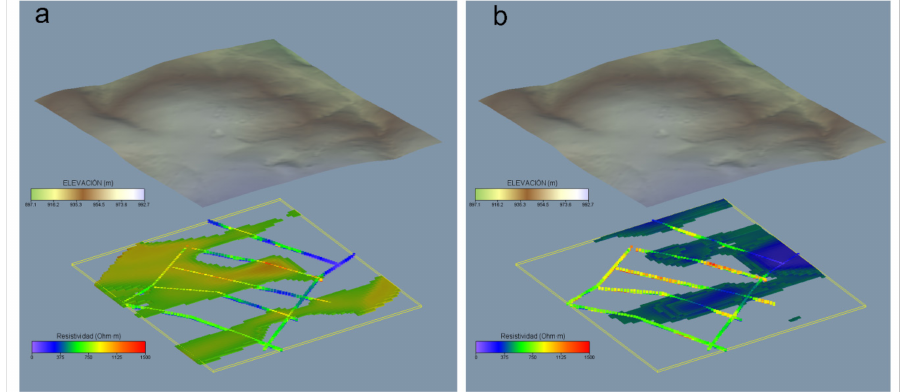
Figure 10. Spatial distribution of real resistivities obtained from tomography inversion. ( a ) ρ values > 700 Ω m, ( b ) ρ values < 500 Ω m.